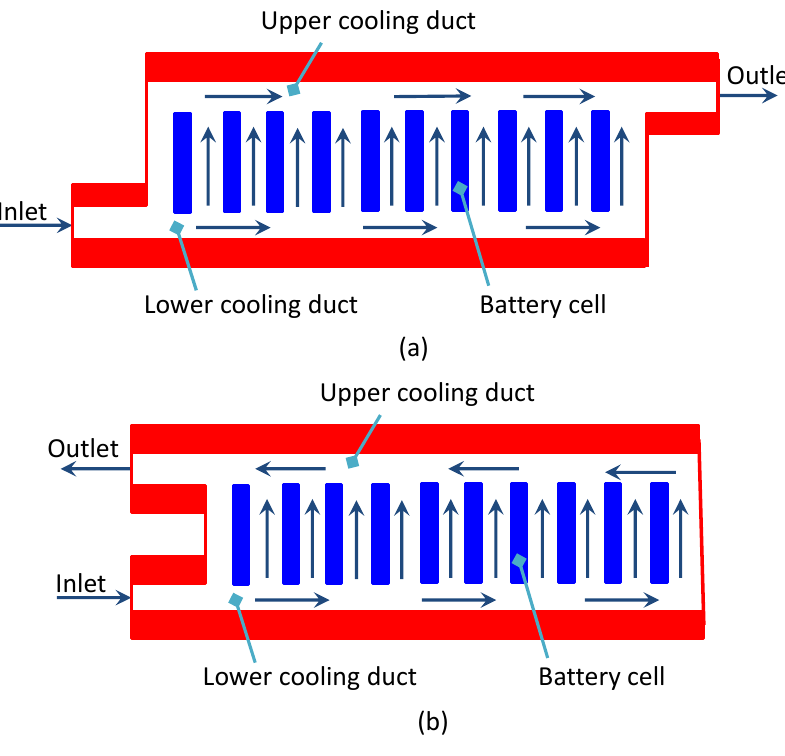
Figure 1. ( a ) Z-type flow arrangement [19]; ( b ) U-type flow arrangement [20].